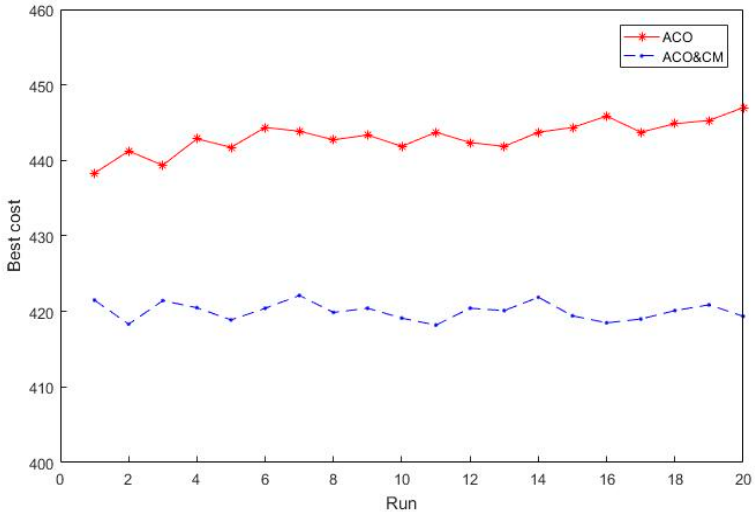
Figure 8. Comparison of the cost of ACO and ACO&CM.